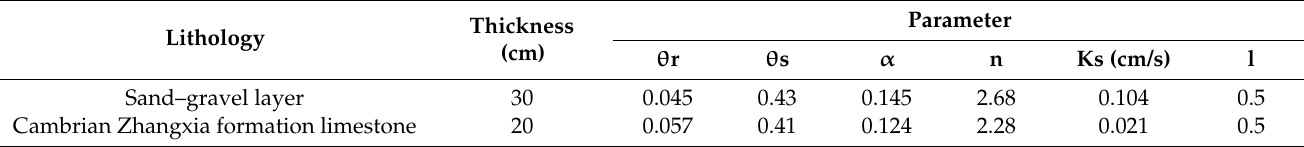
Table 2. Soil parameters of the model.